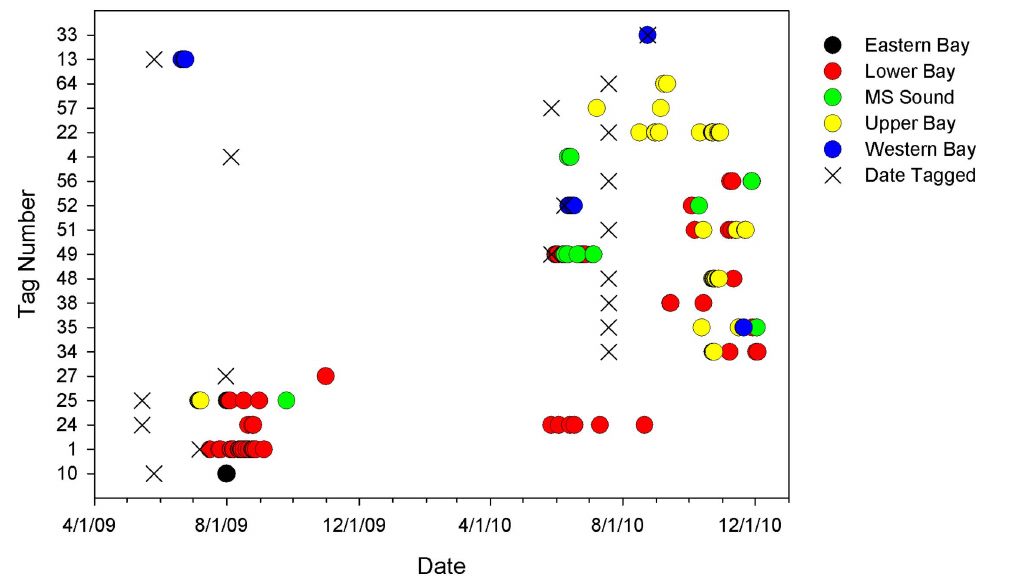
Figure 3. Presence history for acoustically tagged bull sharks. Data are shown for sharks detected in 2009 and 2010, coded by region. The gray area indicates the period when acoustic receivers were not deployed. X’s mark the dates tags were deployed on sharks. doi:10.1371/journal.pone.0097124.g003 receiver operating curves (ROC). Values of ROC range from performance is no better than random. Values greater than 0.8 0.5 to 1, where 1 suggests perfect discrimination between are considered very good, and values above 0.9 excellent [15]. presence and absence probabilities, and 0.5 suggests the model